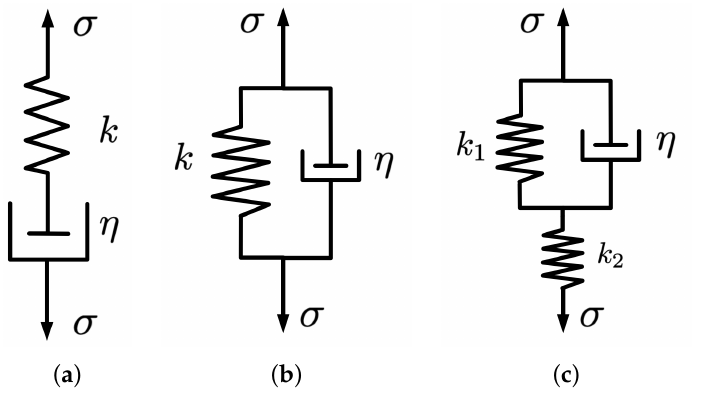
Figure 2. Schematic representation of some standard models based on mechanical